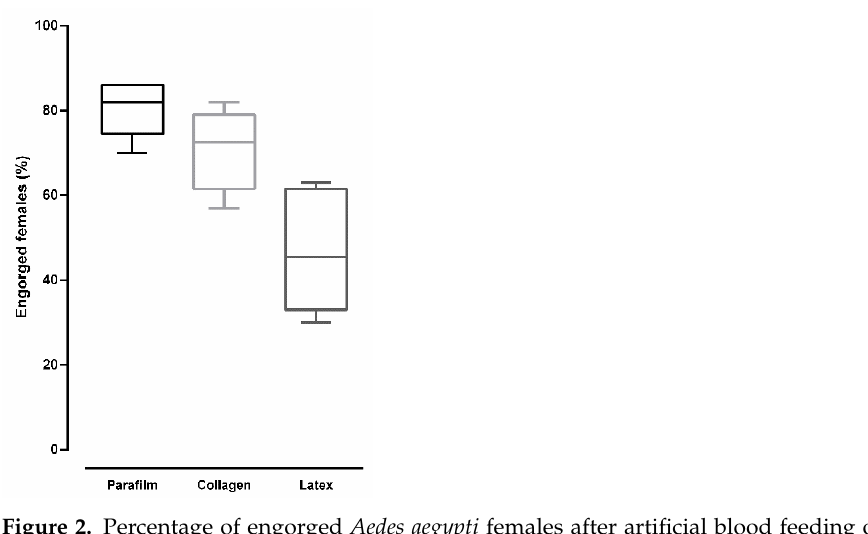
Figure 2. Percentage of engorged Aedes aegypti females after artificial blood feeding on different membranes (bars = ±SEM).